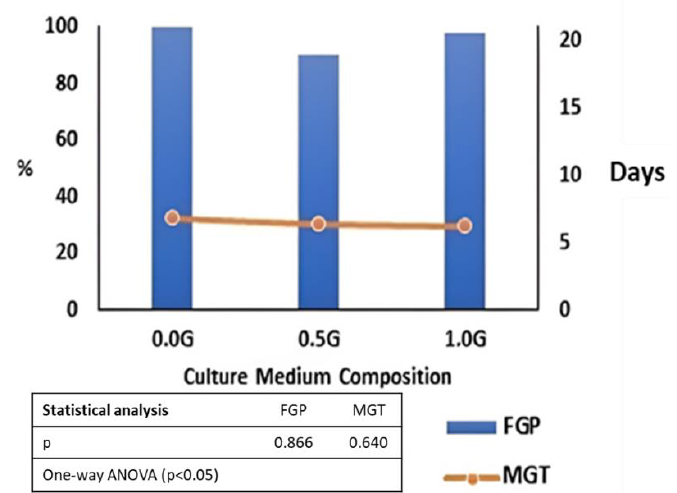
Figure 4. Final Germination Percentage (FGP) and Mean Germination Time (MGT) of in vitro cultured Moringa seeds, sown with increasing concentrations of gibberellic acid (GA 3 ): 0 (0.0 G), 0.5 (0.5 G) and 1 (1.0 G) mg/L of GA 3 .